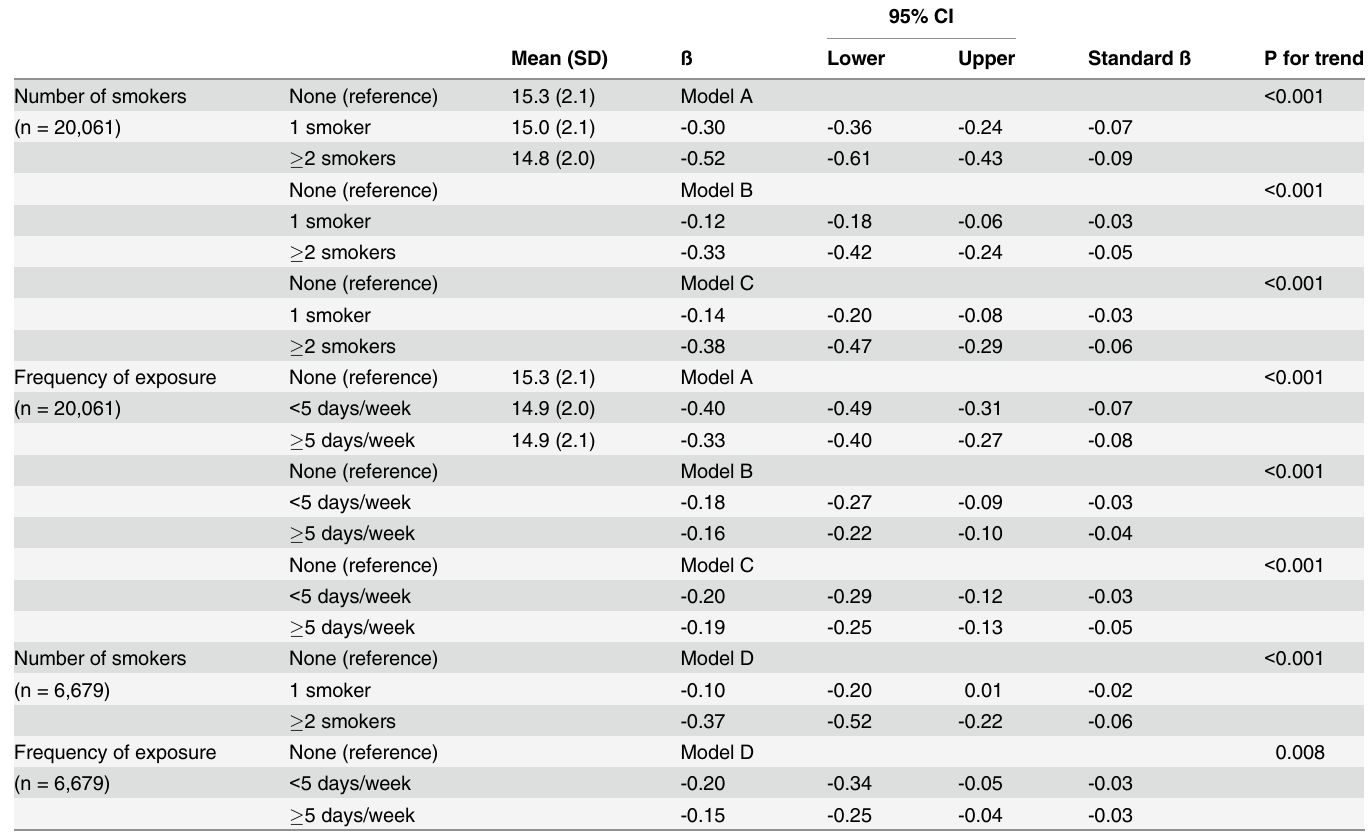
Table 2. Linear regression between childhood passive smoking exposure and age at menarche (continuous) in women who had never smoked.